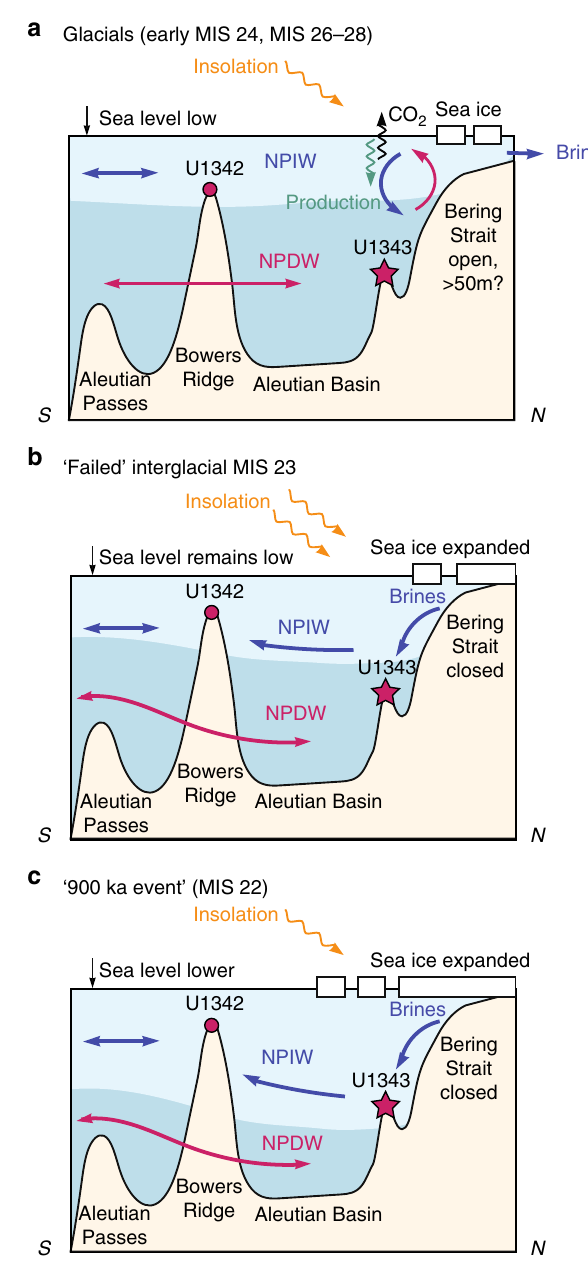
Fig. 4 Schematic Bering Sea cross section (N-S) showing palaeoceanographic interpretations. a Glacials between MIS 24 – 28 (before 930 ka). b ‘ Failed ’ interglacial MIS 23. c Glacial MIS 22 (the ‘ 900 ka event ’